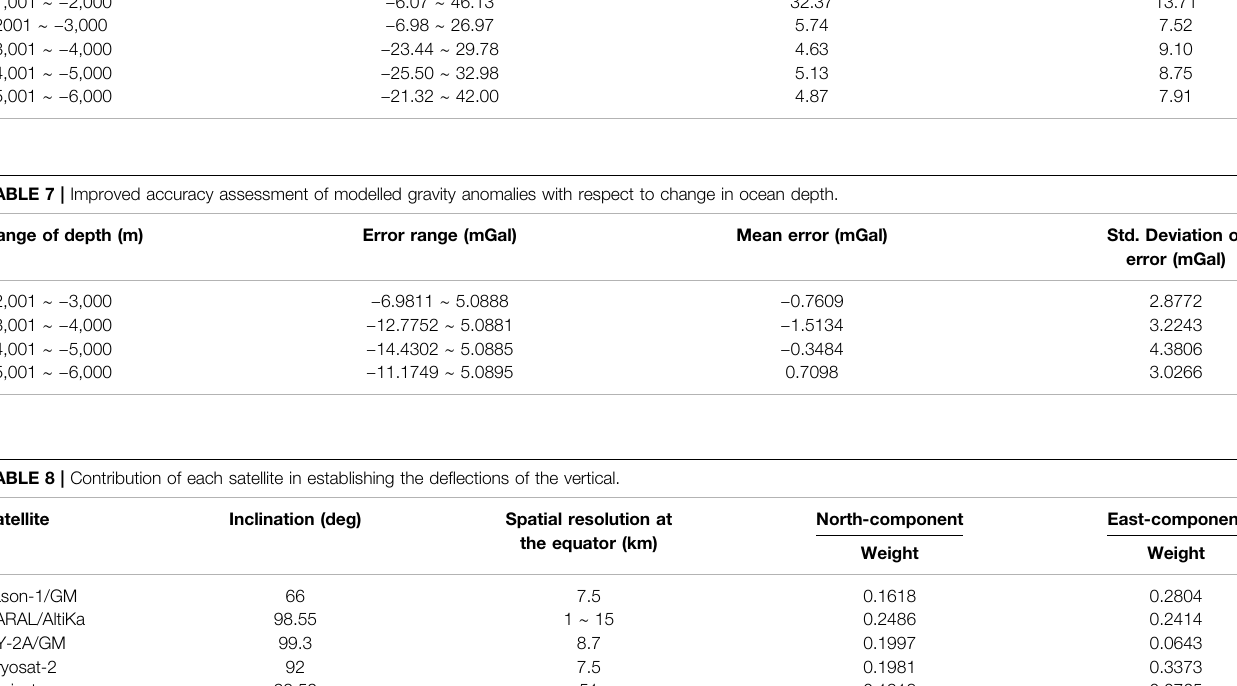
TABLE 6 | Initial accuracy assessment of modelled gravity anomalies with respect to change in ocean depth. Range of depth (m) Error range (mGal) Mean error (mGal) Std. Deviation of − 1,001 ∼ − 2,000